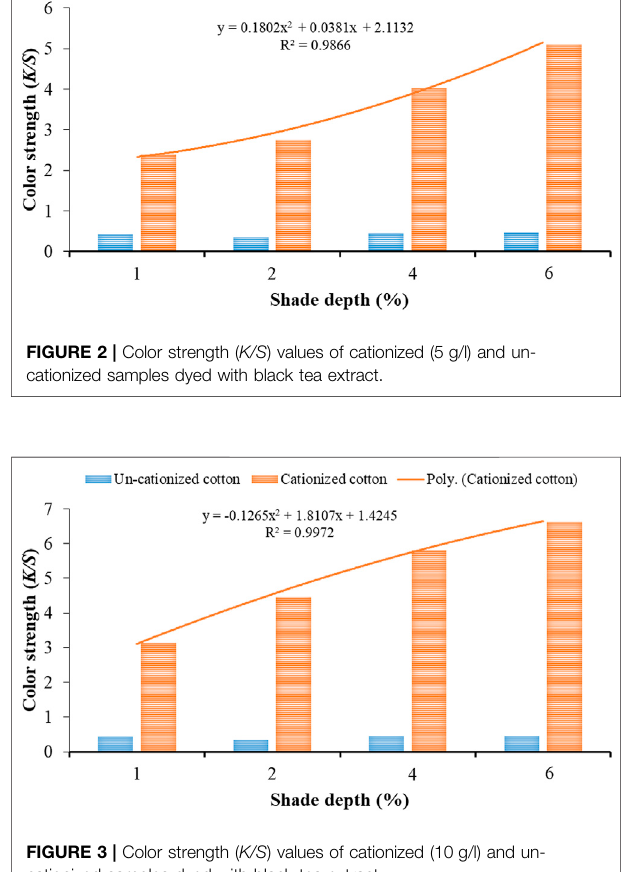
FIGURE 3 | Color strength ( K/S ) values of cationized (10 g/l) and un- cationized samples dyed with black tea extract.